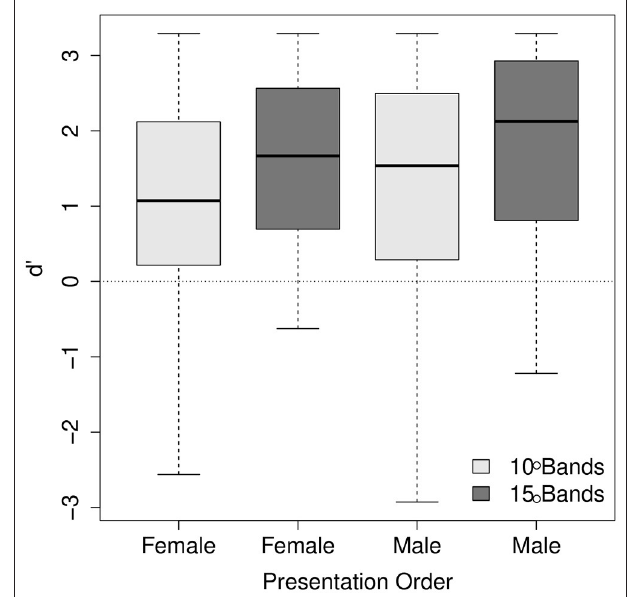
FIGURE 5 | The interaction between the number of frequency bands and the order of presentation. In the x-axis, the labels “Female” and “Male” indicate the voice listeners heard